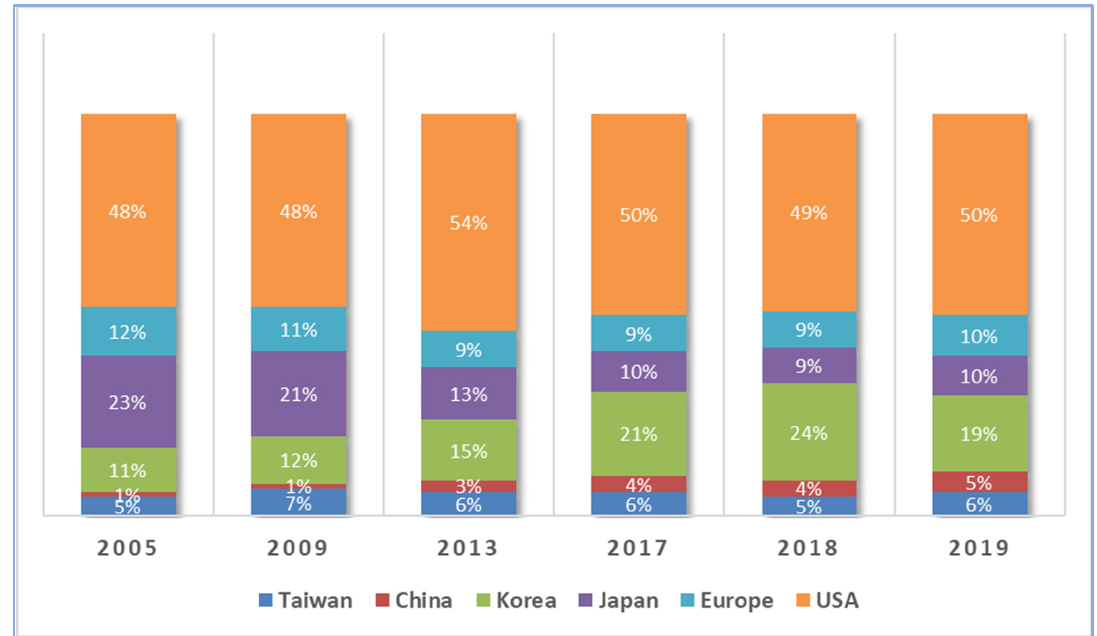
Figure 3. Development of market shares of sales by company headquarters [3].